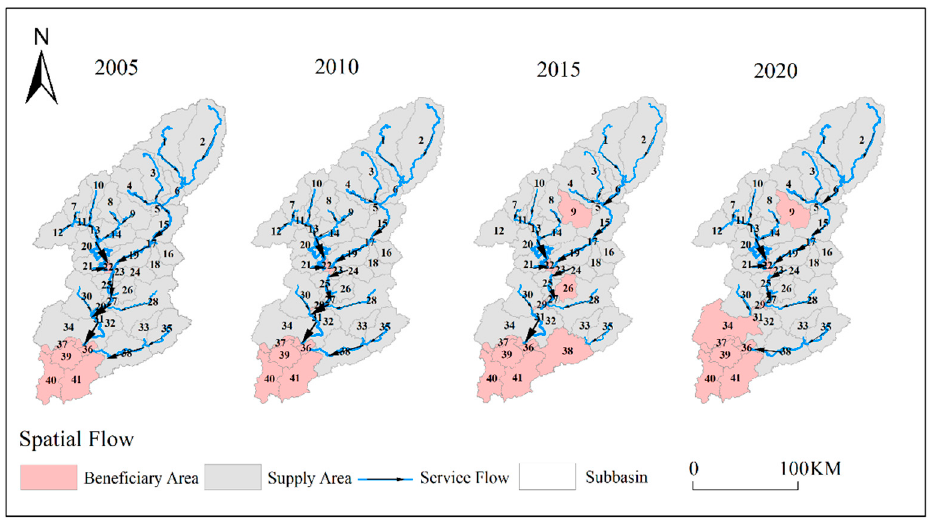
Figure 8. The spatial flow of water resources.